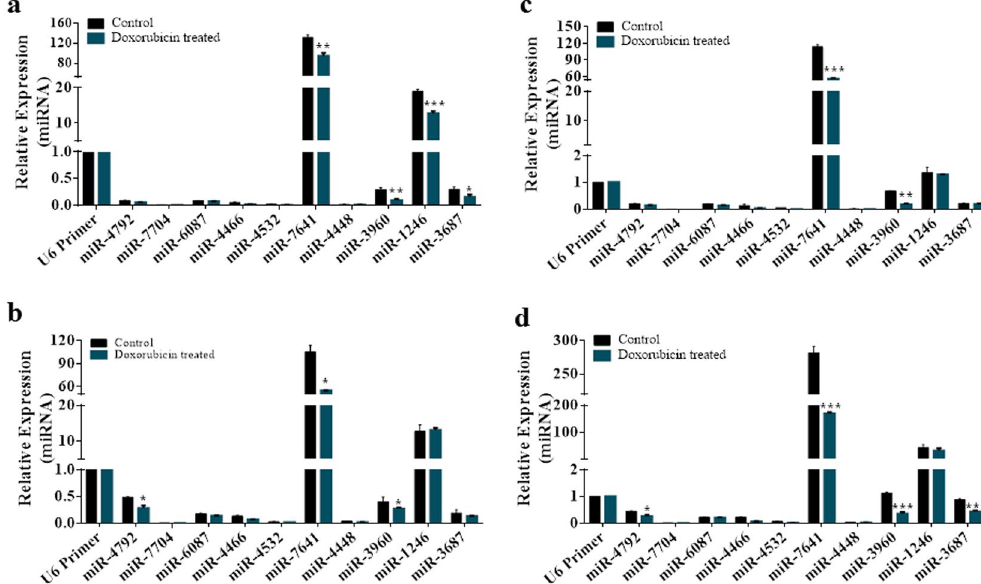
Figure 2. Doxorubicin-mediated regulation of miRNA expression in cancer cells. ( a ) Bar diagram presenting miRNA expression in doxorubicin treated and untreated MCF-7 breast cancer cells. Significant downregulation was observed for several miRNAs upon doxorubicin treatment, such as miR-7641 ( p < 0.01), miR-3960 ( p < 0.01), miR-1246 ( p < 0.001), and miR-3687 ( p < 0.05). ( b ) As shown in the bar diagram, significant downregulation of miR-4792, miR-7641, and miR-3960 ( p < 0.05) was observed in doxorubicin treated MDA-MB-231 breast cancer cells compared with untreated control cells. ( c ) Bar diagram showing that doxorubicin treatment resulted in significant downregulation of miR-7641 and miR-3960 expression ( p < 0.001, p < 0.01, respectively) in HT-29 colon cancer cells. ( d ) As shown in bar chart, doxorubicin treatment downregulated the expressions of several miRNAs, including miR-4792 ( p < 0.05), miR-7641 ( p < 0.001), miR- 3960 ( p < 0.001), and miR-3687 ( p < 0.001) in HCT116 colon cancer cells. Bar diagram shows the mean ± SD obtained from triplicate experiments. * p < 0.05, ** p < 0.01, and *** p <